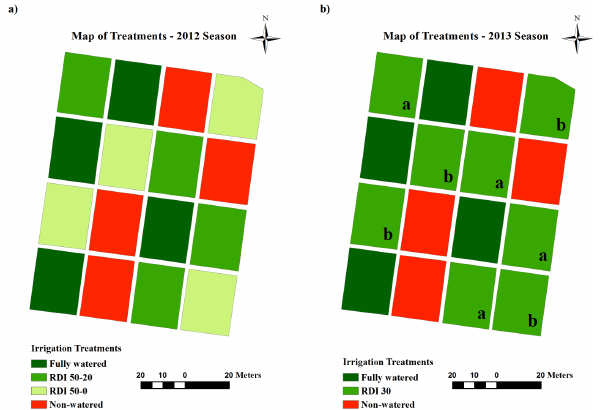
Figure 1. Maps of treatments and respective plots: (a) map of treat- ments of 2012 growing season; (b) map of treatment of 2013 grow- ing season, where “a” and “b” replicates of RDI 30 are in the same emplacement of the respective replicates of RDI 50-20 and RDI 50- 0 of the previous